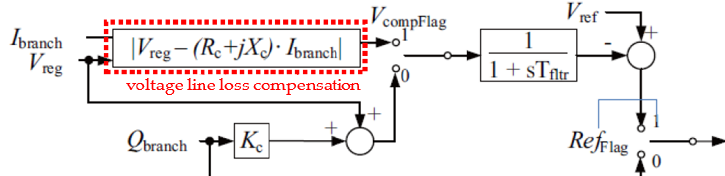
Figure 5 . The voltage feedback control block diagram of the REPC .